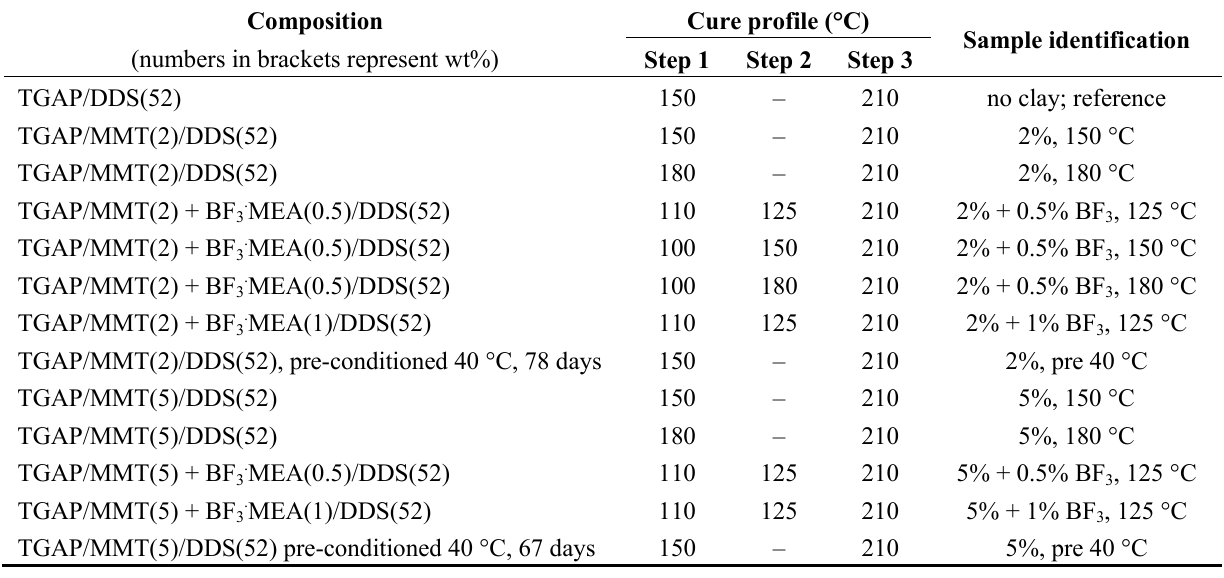
Table 1. Sample identification for different compositions and preparation conditions of TGAP/clay nanocomposites prepared for impact